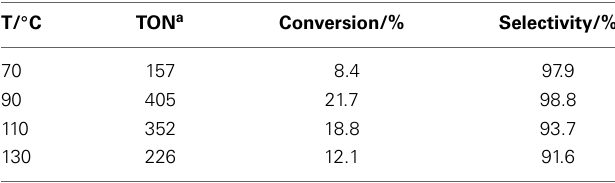
Table 2 | The effect of reaction temperature in the telomerization of 1,3-pentadiene with methanol catalyzed by Pd(IMes)(dvds). T/ ◦ C